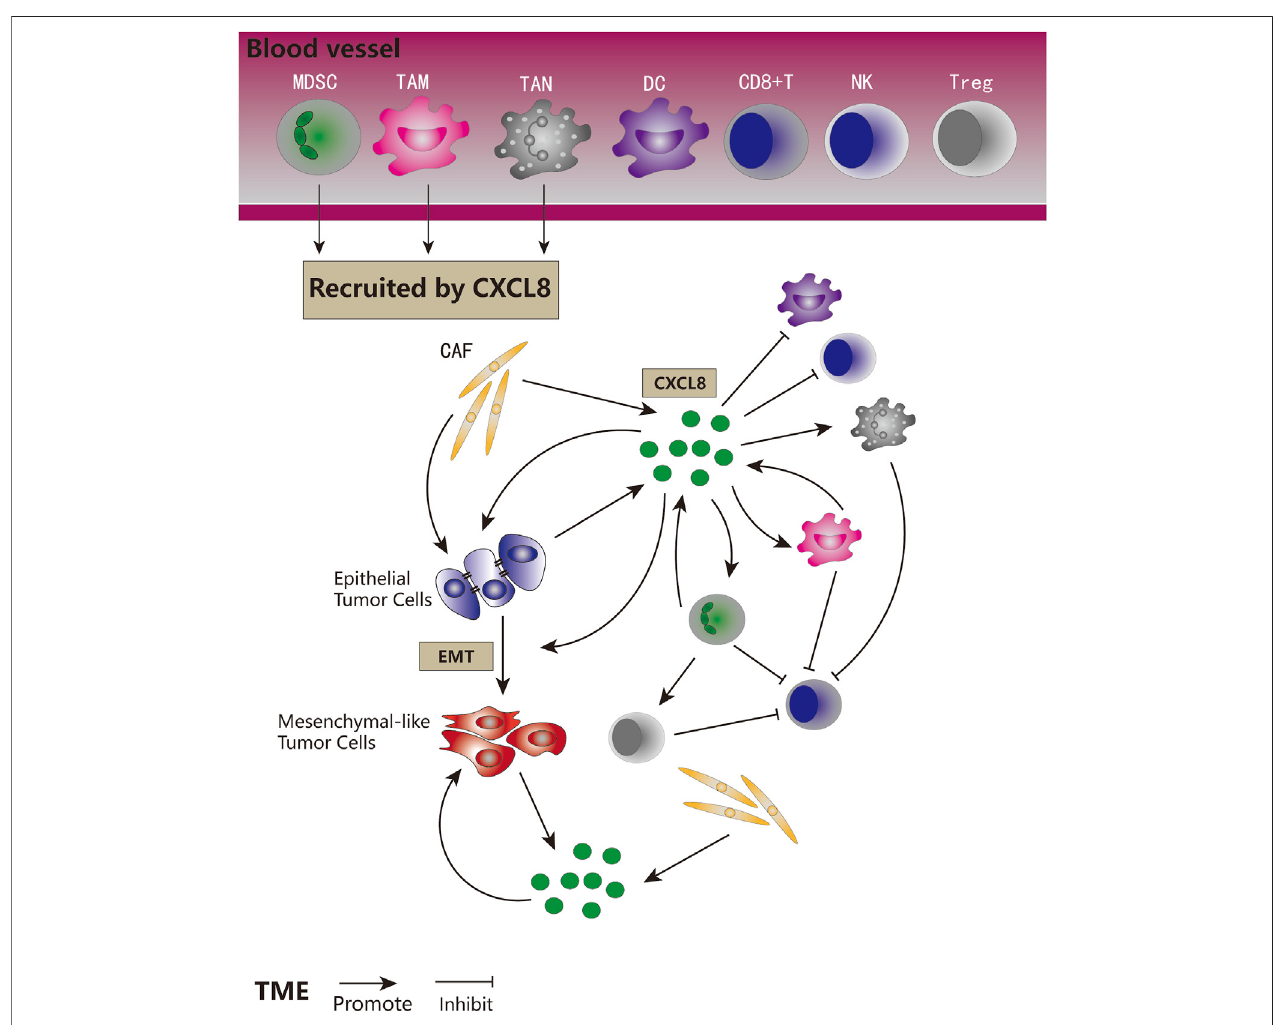
FIGURE4| The roleof CXCL8 signaling in tumor biology. CXCL8 recruited MDSCs, TAMs, and TANs tothe TME. CXCL8 could be secreted by tumor cells, CAFs, MDSCs,andTAMs.CXCL8couldpromotetumorcellsproliferationandEMT,directlyandindirectly.CXCL8couldfacilitatetheaccumulationofpro-tumorigenicimmune cells and tumor immune suppression, and inhibit anti-tumor immune cells in direct and indirect